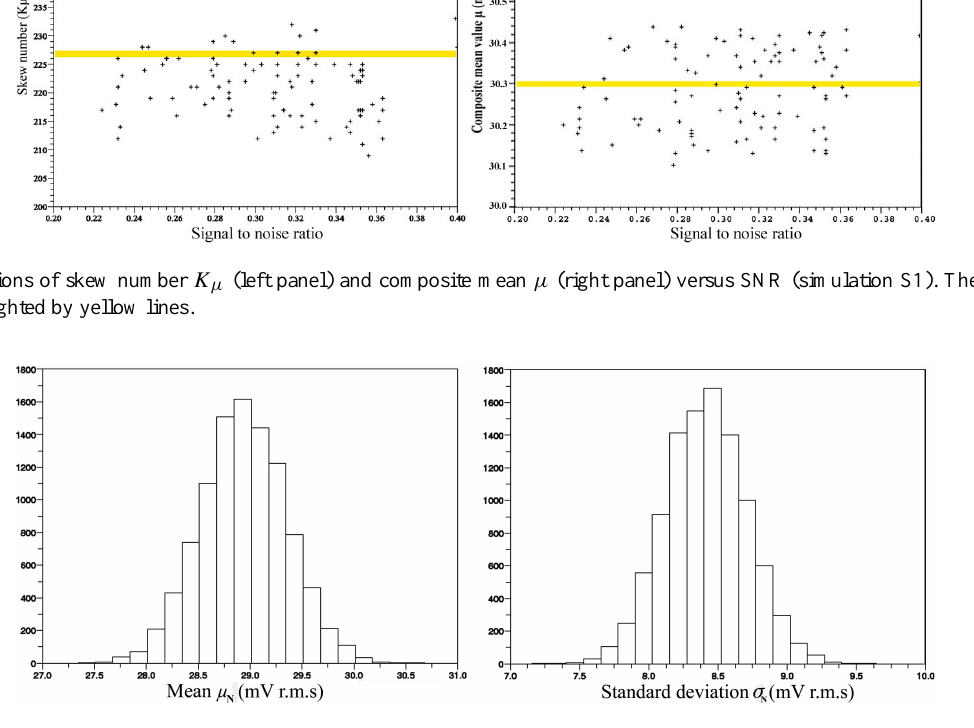
Fig. 9. Distribution of mean and standard deviation of LFR noise files derived from 10000 pairs of 418 samples used in simulation S2, assuming a normal distribution with expected values of µ N and σ N equal to 30 and 8.7mV RMS,